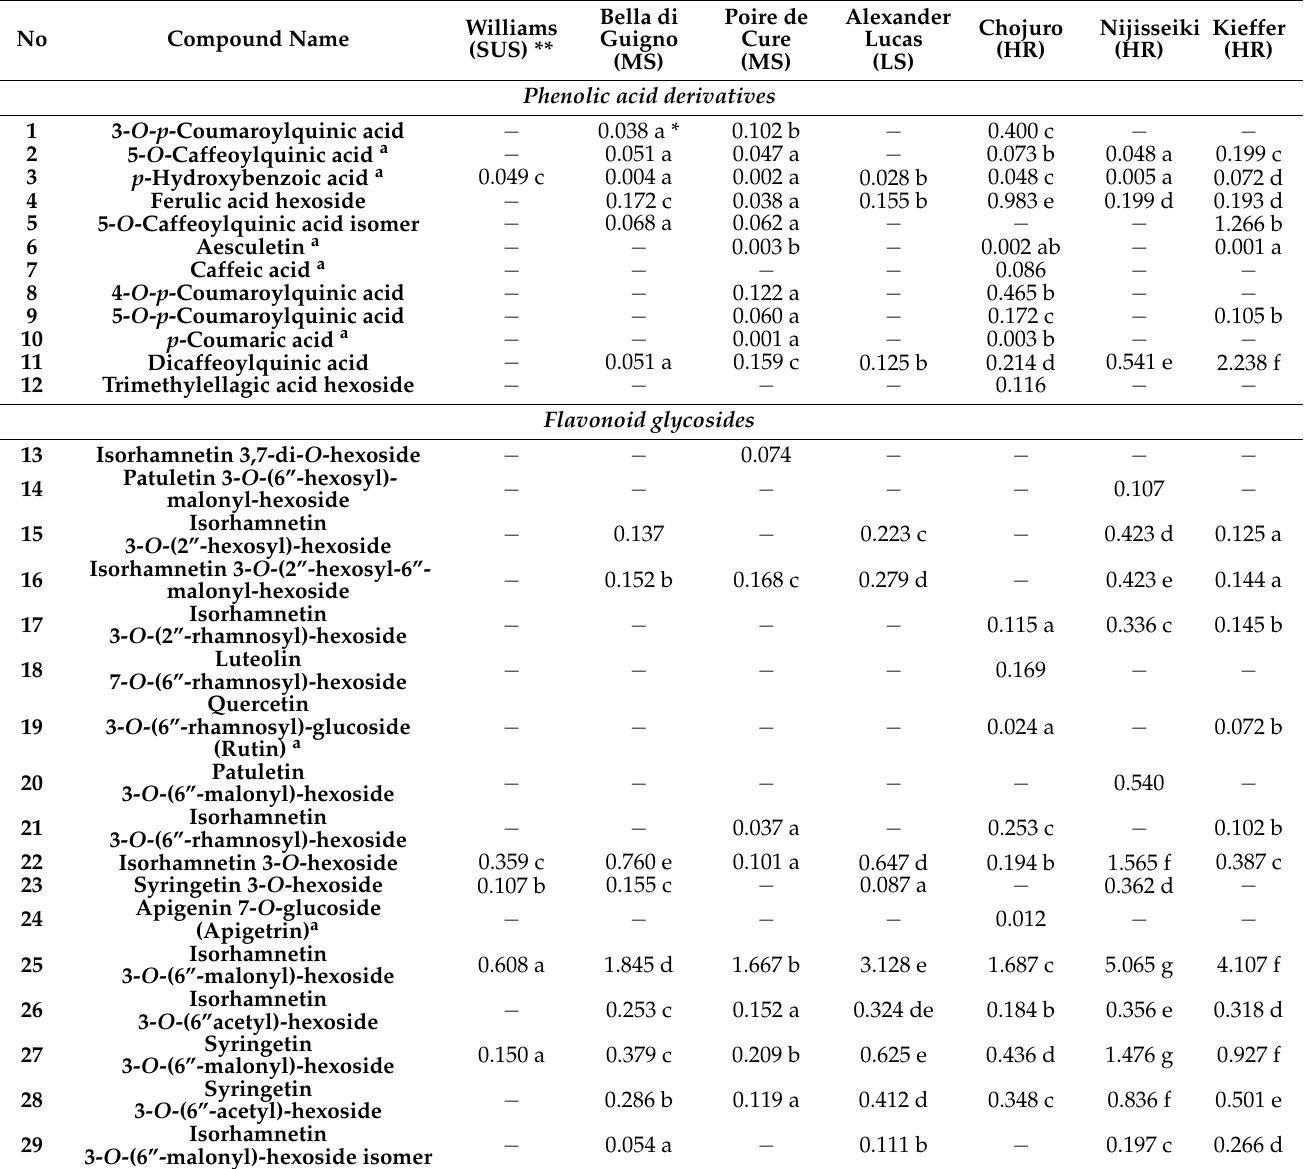
Table 4. The individual polyphenolic content ( µ g/mL) determined by LC/MS in seven pear